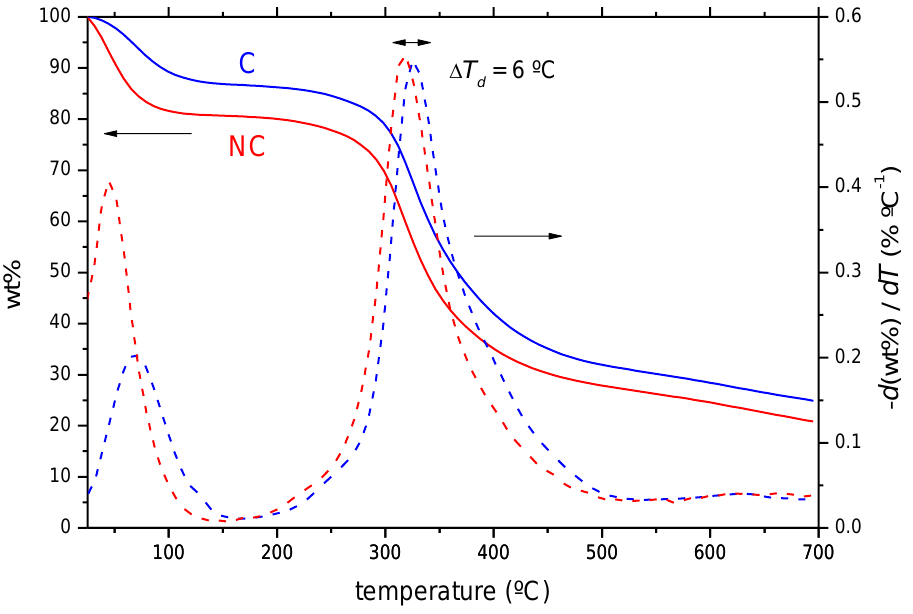
Figure 1. Thermogravimetric profiles (TGA and DTG) of chrome-tanned (C) and chromium-free (NC) leather wastes.